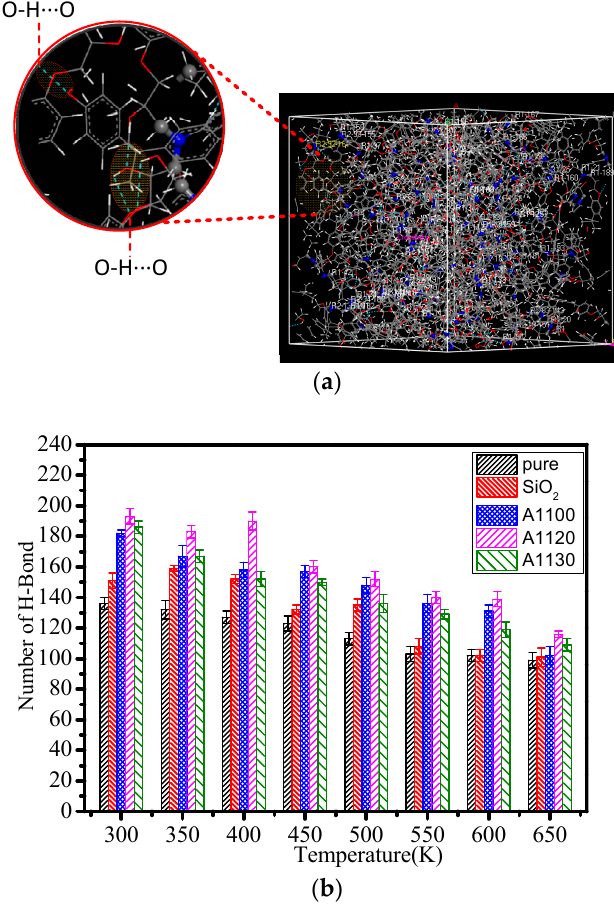
Figure 7. ( a ) Schematic diagram of the hydrogen bond formed by the cross-linked epoxy resin, in the form of a blue dotted line in the yellow shade, the hydrogen bond, here is the OH ··· Htype hydrogen bond; ( b ) number of hydrogen bonds at different temperatures.